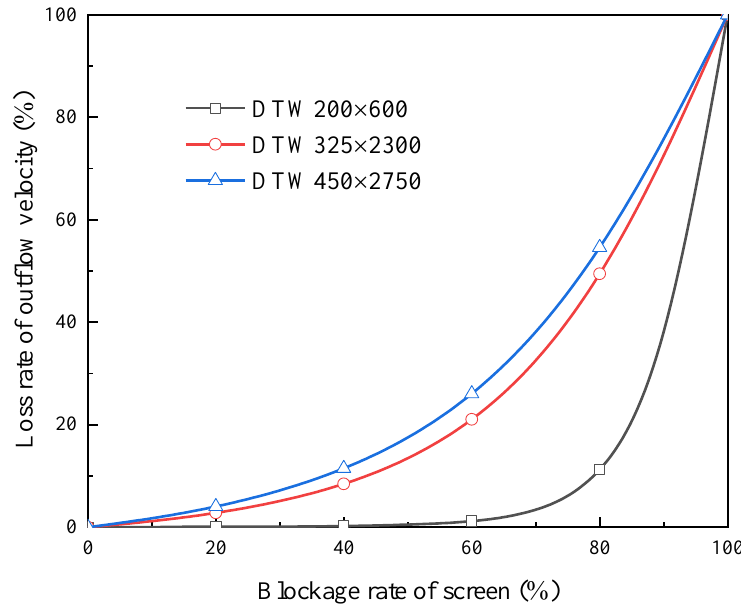
Figure 12. Characteristic curves influenced by the fineness of screen mesh.